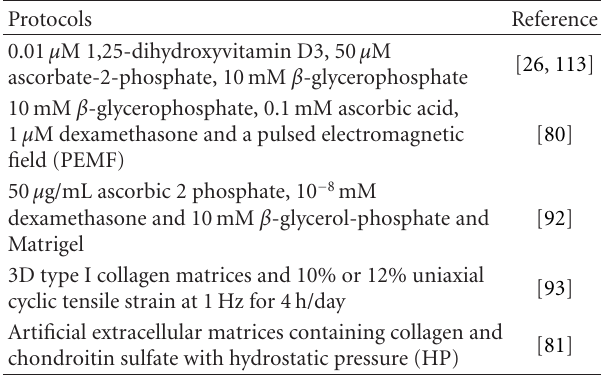
Table 2: Osteogenic di ff erentiation factors.